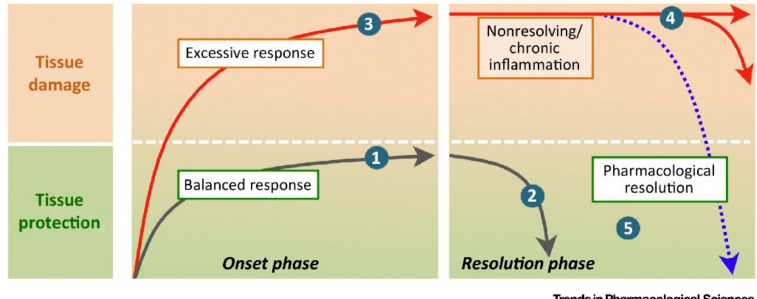
Figure 1. Time phase engagement of proresolving mediators. Inflammation is a physiological